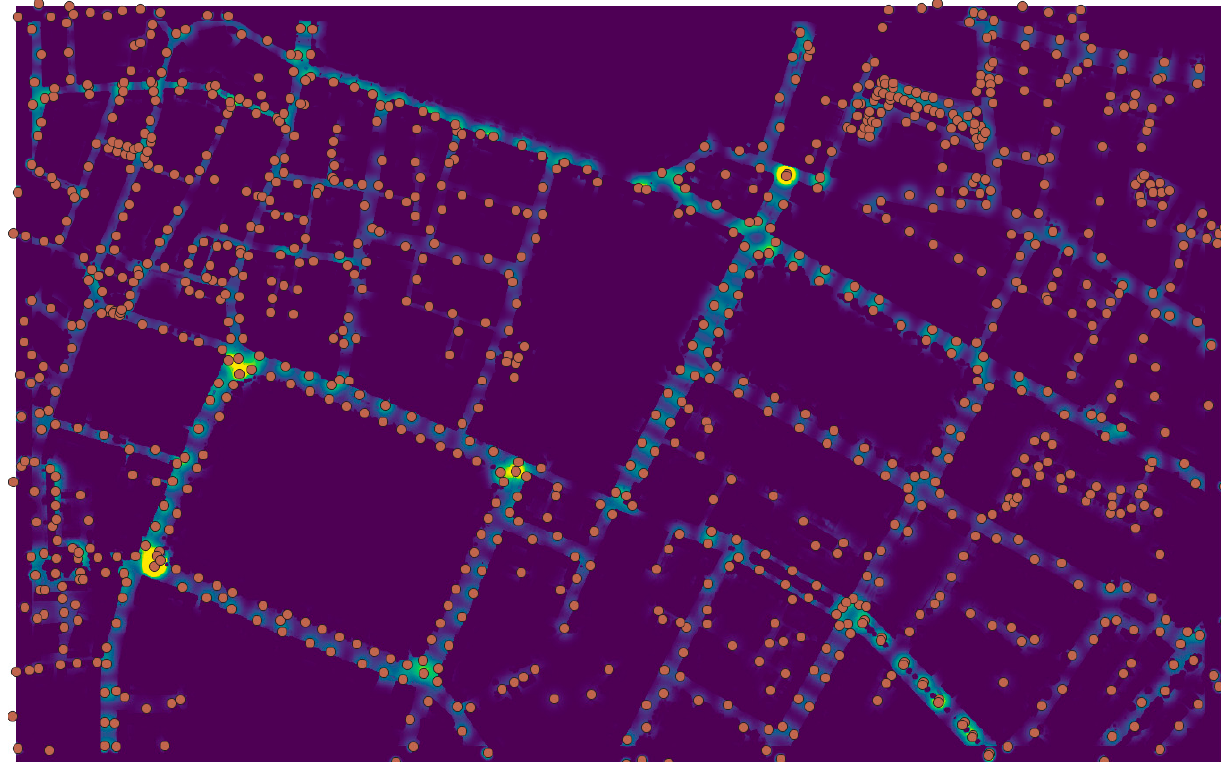
Figure 3. False colour image of the diffuse flighting model for the Dublin City test area with the locations of streetlights superimposed. The fraction of diffuse light to the zenith was reduced by 58% due to the effect of obstructions, including by the tree-lined interior of St. Stephen’s Green in the bottom left of the image. The image is approximately 1.5 × 0.96 km in size.